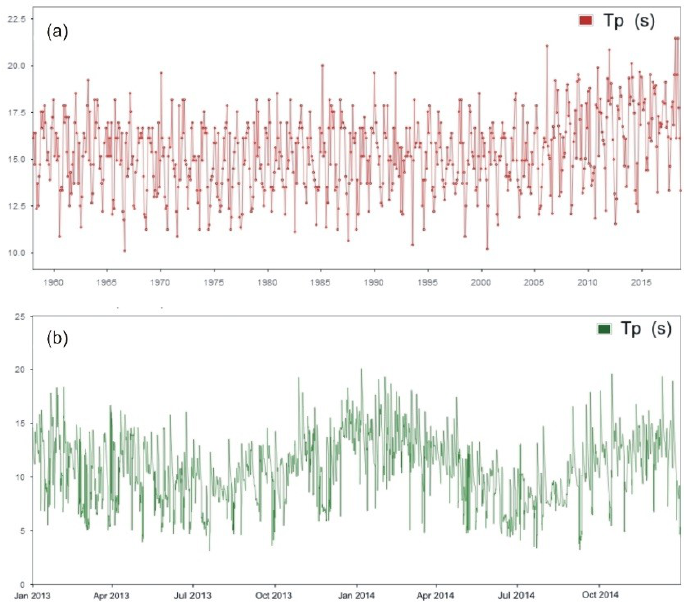
Figure 9. Maximum monthly value ( a ) for the wave crest time period (seconds), Tp; and hourly values ( b ) of Tp variable in the 2013–14 winter season.